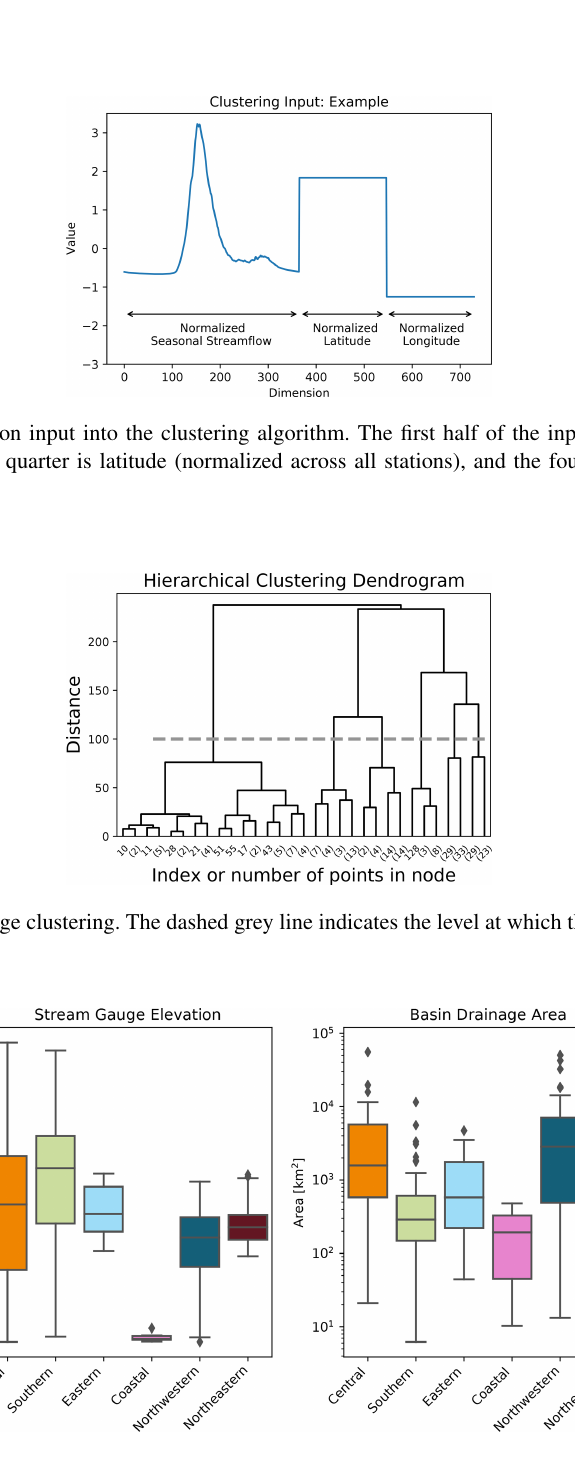
Figure A3. Elevation and drainage area of stations within each of the identified clusters. Station elevation is calculated from a digital elevation model from the Shuttle Radar Topography Mission (SRTM) at 90m resolution (Farr et al., 2007). The drainage area is taken from the Environment Canada HYDAT database (Water Survey of Canada HYDAT data). The coastal cluster is at the lowest elevation and with the smallest drainage areas. Clusters in mainland British Columbia (central, southern, and northwestern) span wide ranges of elevation and drainage area, while clusters in Alberta (eastern and northeastern) span narrower ranges of elevation and drainage